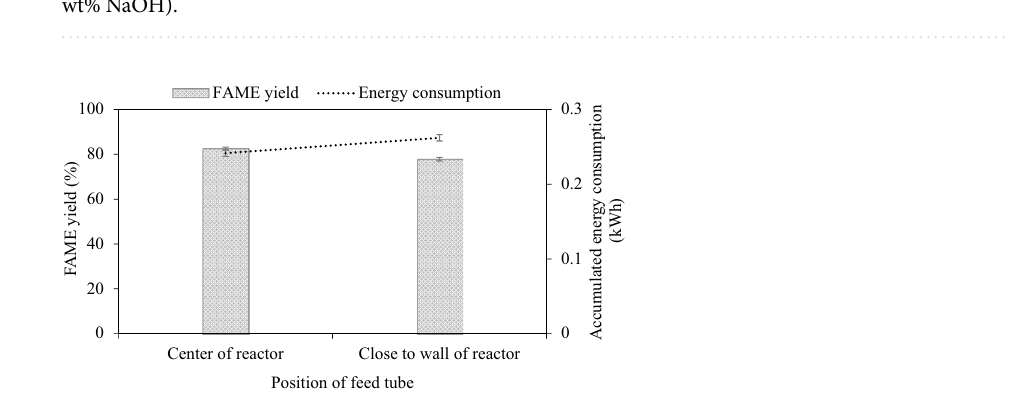
Figure 6. Effect of reactant discharge position on steady-state FAME yield (refined palm oil, 2000 mL, 50 mL/ min, 1 wt% NaOH, 62–63